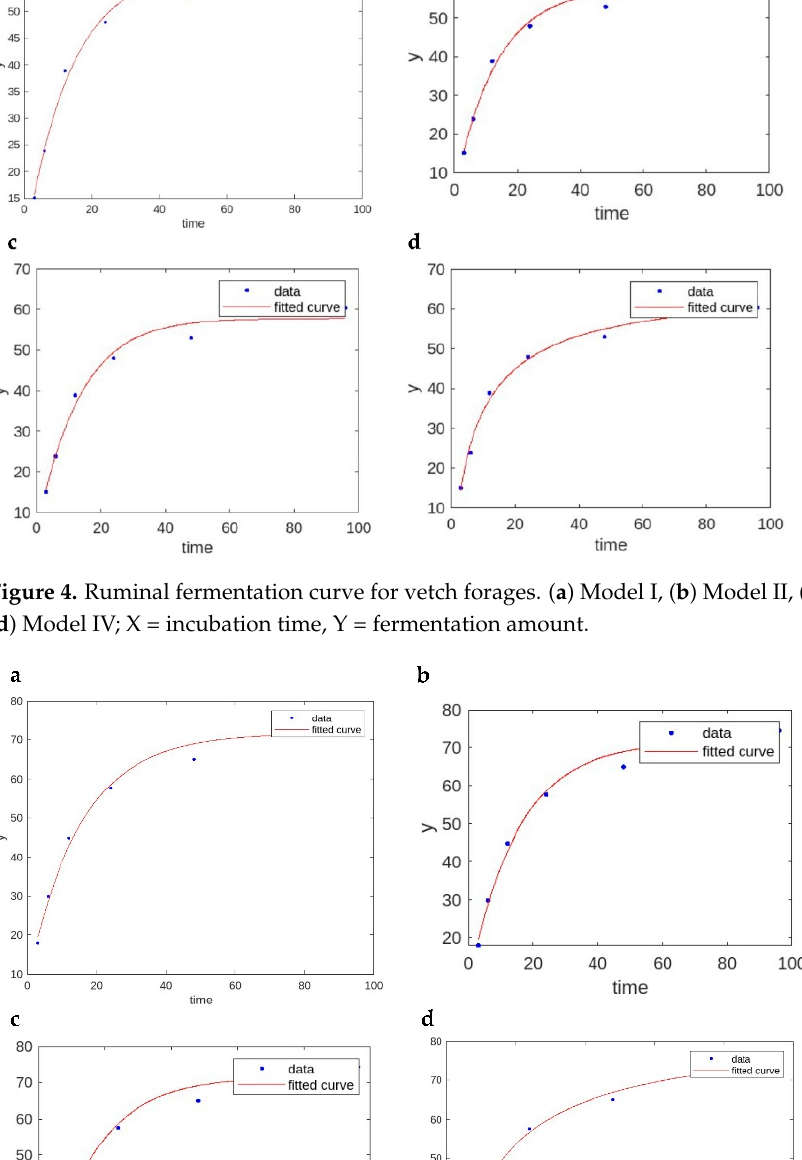
Figure 3. Ruminal fermentation curve for alfalfa forages. ( a ) Model I, ( b ) Model II, ( c ) Model III, and ( d ) Model IV; X = incubation time, Y = fermentation amount.